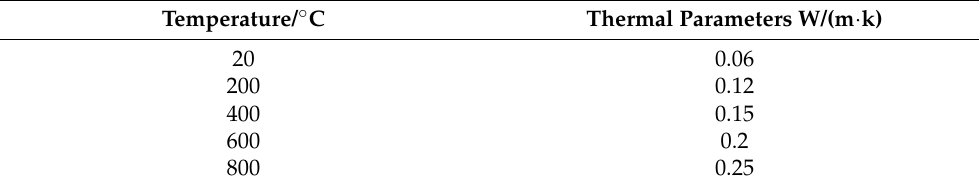
Table 5. Thermal parameters of ceramic fiber